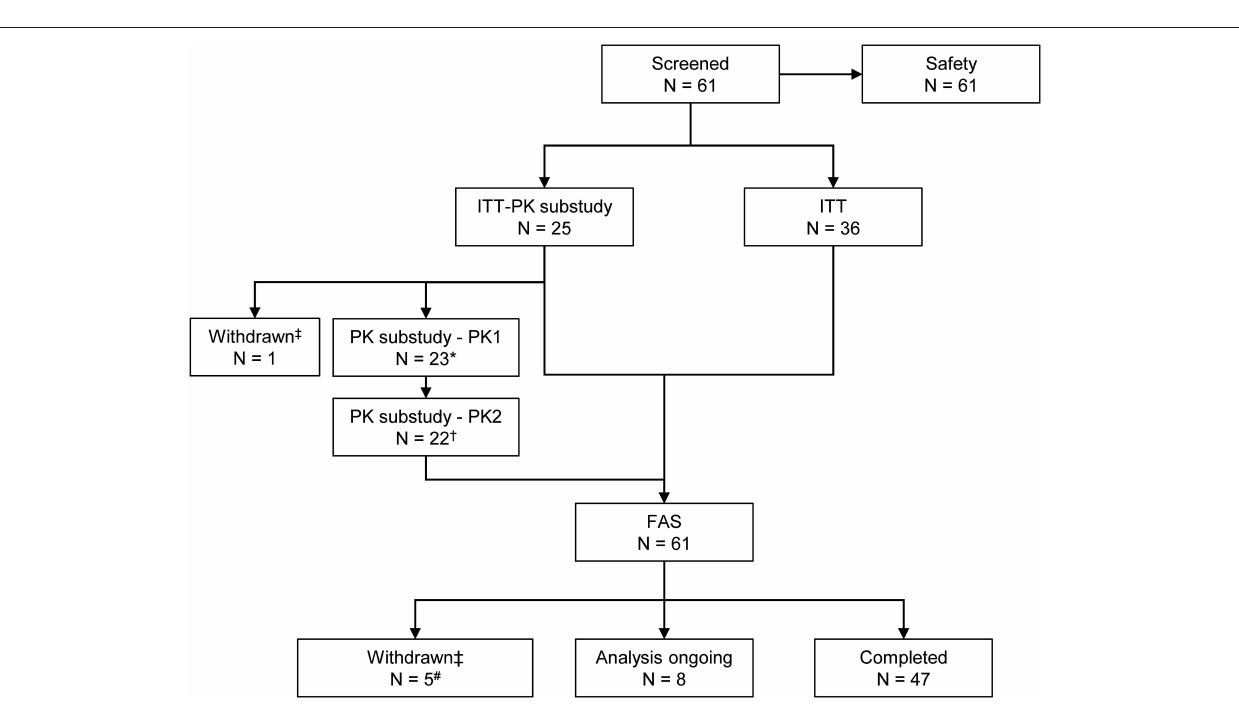
FIGURE 2 | Patient disposition. *One patient had no blood sampling and did not participate in the PK sub-study. † One patient did not have PK samples available from the PK SC2 sampling time point. ‡ The reason for withdrawal was the patient’s decision in each case. # Three patients withdrew before the start of the primary efficacy period. FAS, full analysis set; ITT, intention-to-treat; N , number of patients; PK,